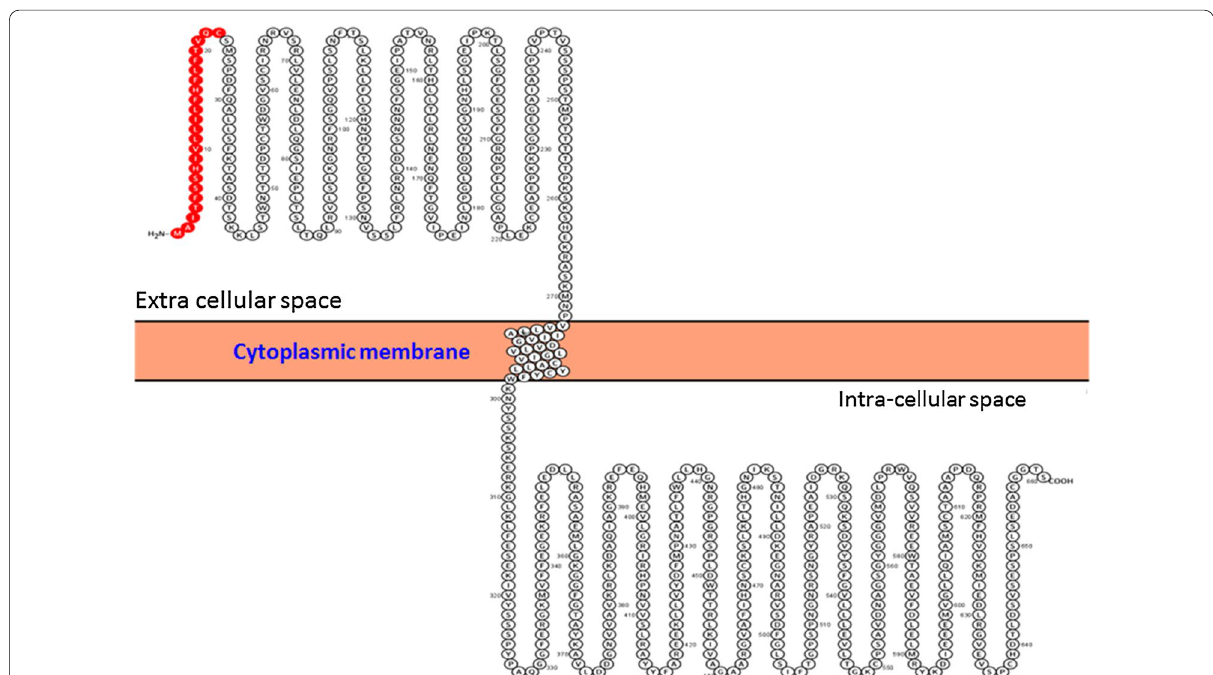
Fig. 7 Schematic representation of the putative protein encoded by the GSH118 gene relative to the cytoplasmic membrane predicted by Protter web tool. The circles are amino acids and numbers show the amino acids position. The red circles are signal peptide’s amino